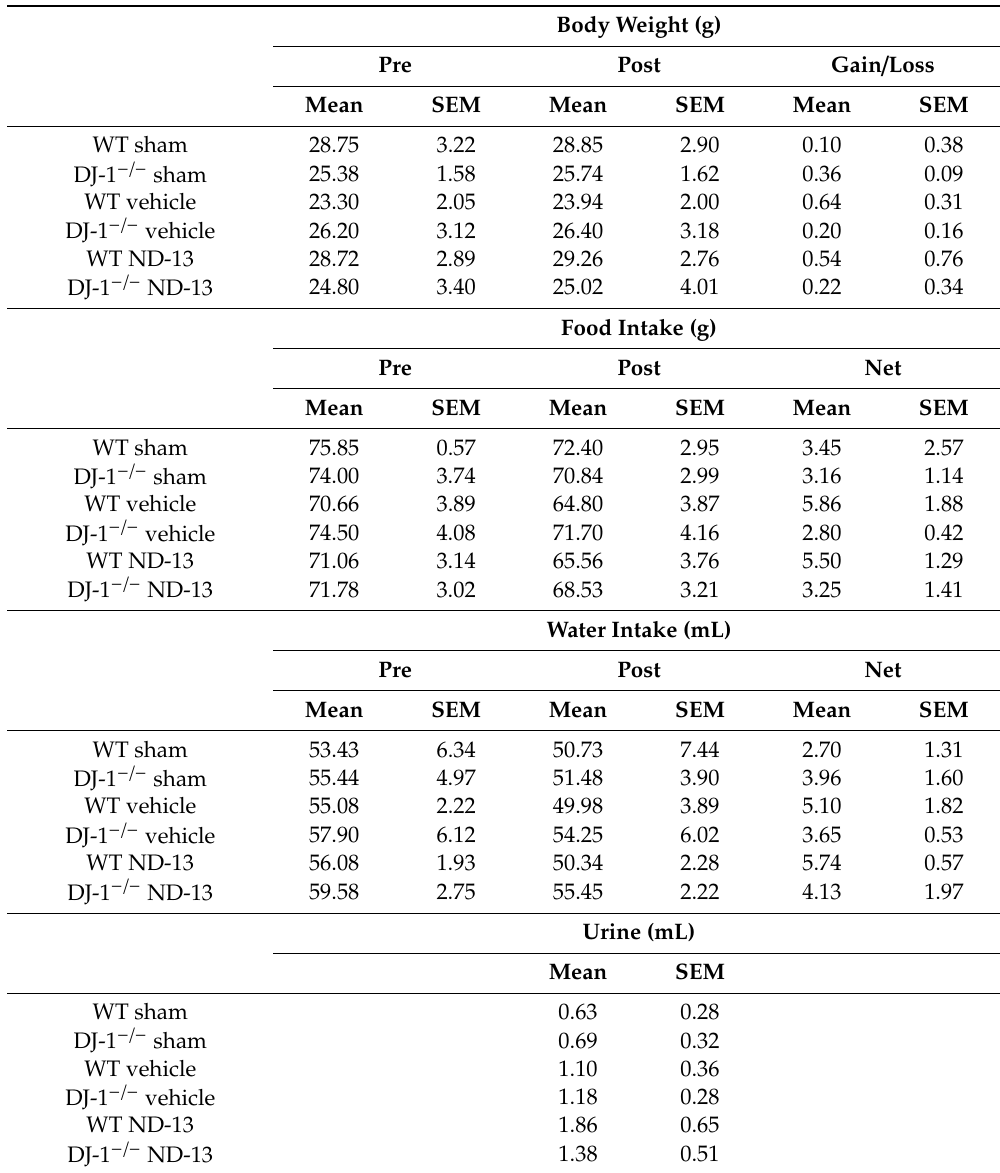
Table 1. Physical characteristics of the experimental